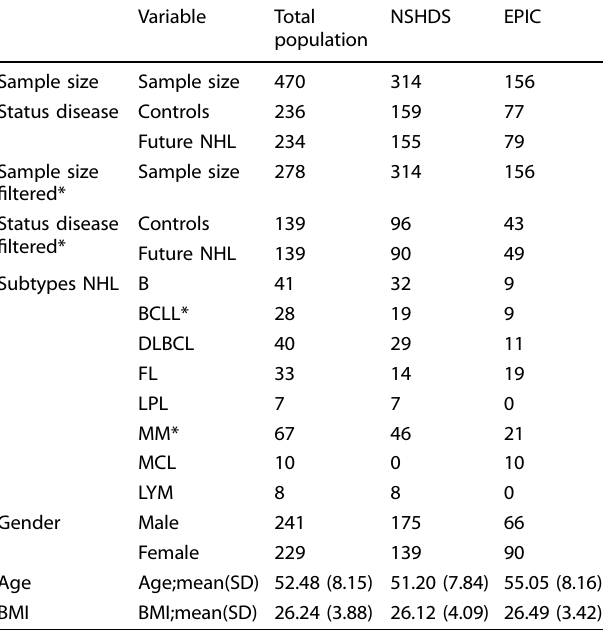
Table 1. Demographics of the study population (470 samples), comprising future Non-Hodgkin Lymphoma (NHL) and controls from two cohorts (Northern Sweden Health and Disease Study [NSHDS] and EPIC-Italy from the European Union 7th Framework